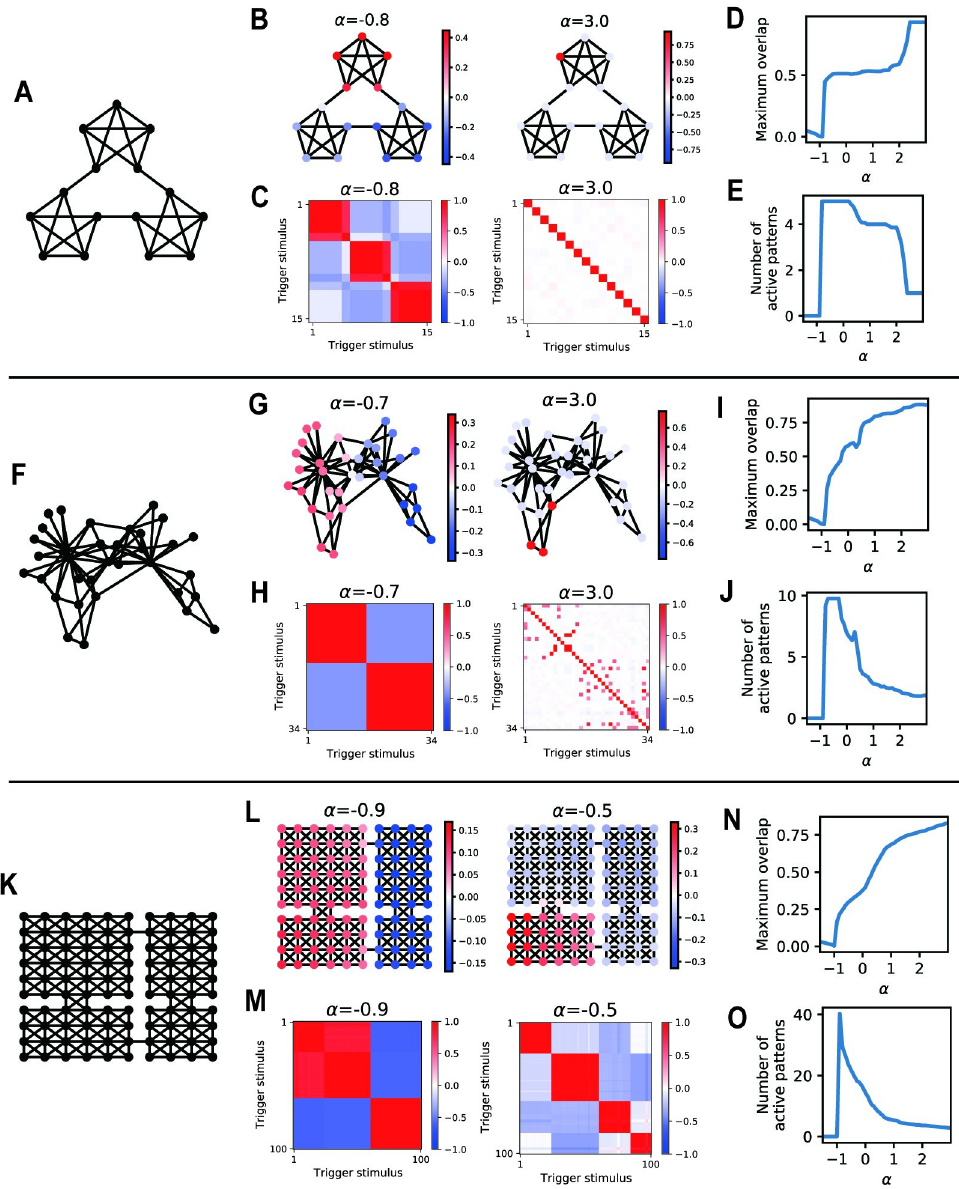
Fig 2. LAM generates multi-scale representations for community structures. (A) Graph used by Schapiro et al. (2013) [6]. (B) Pattern overlaps of example attractors. (C) Correlation matrices between activity patterns in the attractor states reached from different trigger stimuli (trigger nodes). (D) Maximum pattern overlaps obtained by various values of α . (E) Numbers of active patterns obtained by various values of α . In D and E, we averaged values from all attractors reached from different trigger stimuli. (F) Karate club network[34]. (G-J) Results for Karate-club network. (K) A compartmentalized room structure[5,9,10,36](four-room graph). (L-O) Results for a four-room graph.